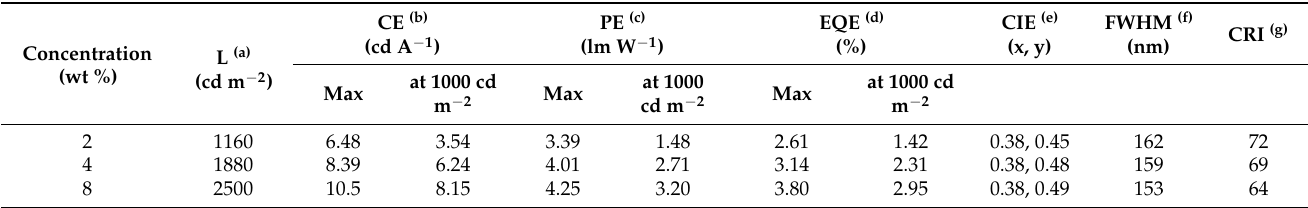
Table 2. Key performances of OLEDs with Cu 2 Cl 2 (P ∩ N) 2